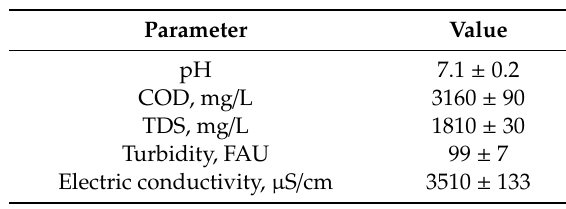
Table 4. Characteristics of the brewery wastewater that was treated with the AMD-PAFS and PFS